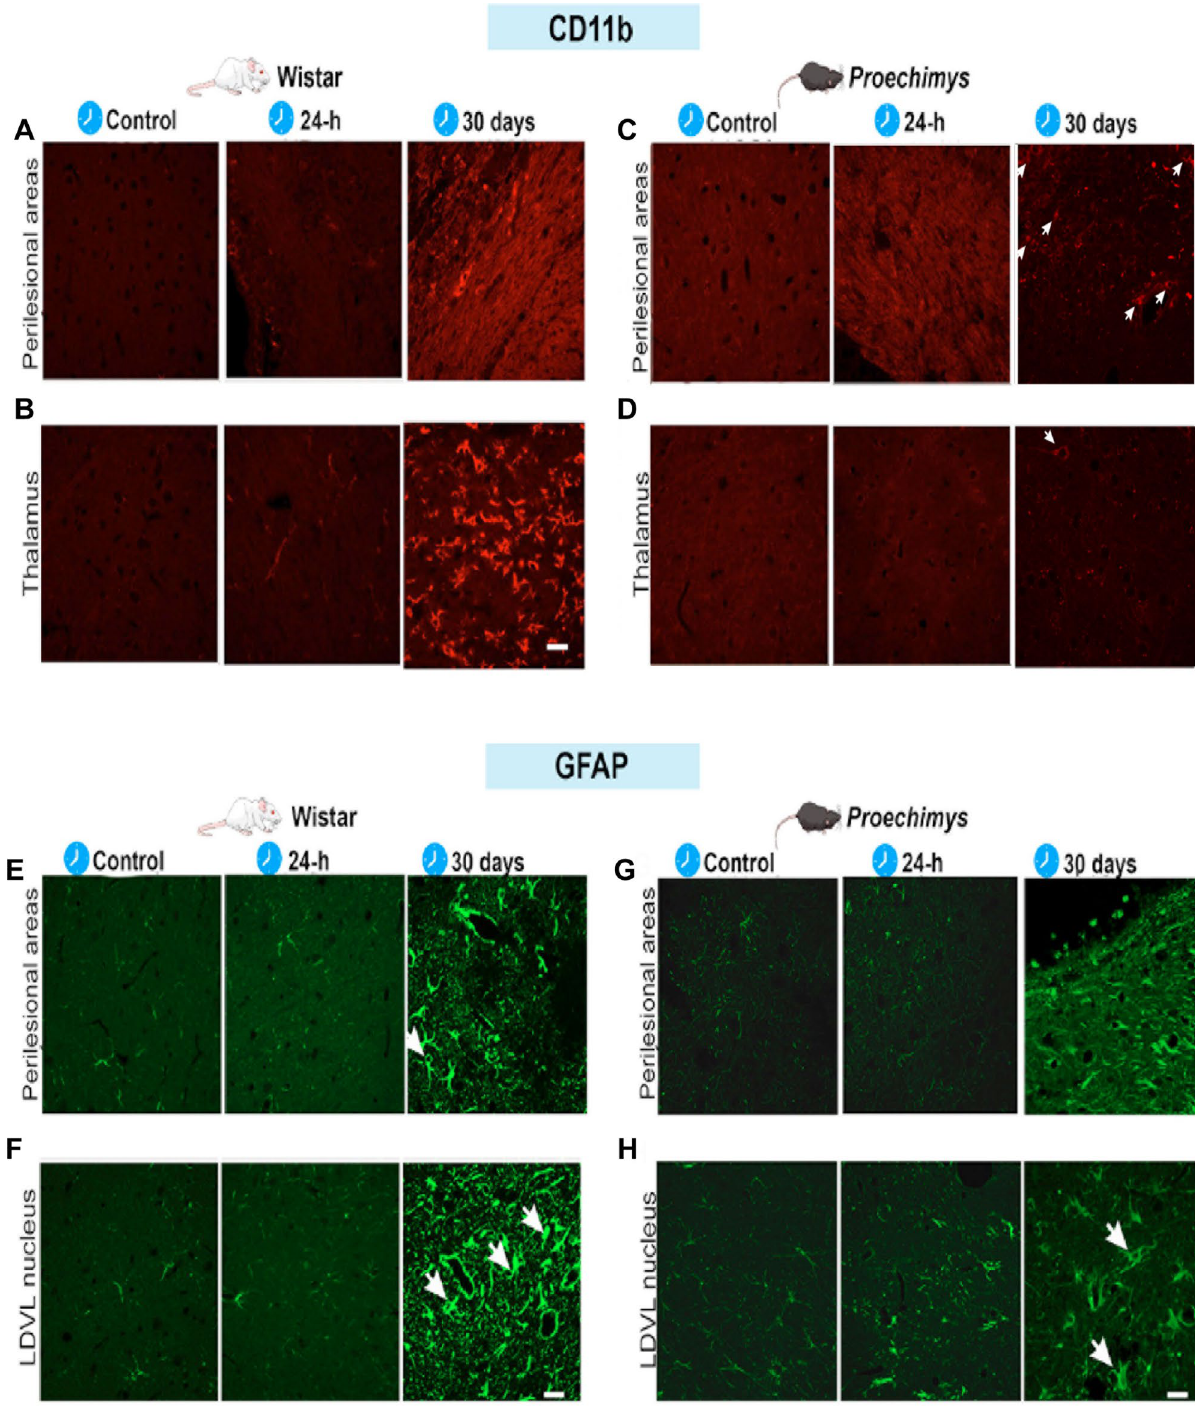
Figure 3. CD11b and GFAP immunofluorescences staining in the perilesional area and thalamus in Wistar and Proechimys . ( A – D ) Representative immunostaining images of CD11b in the perilesional area ( A , C ) and thalamus ( B , D ). Note the absence of CD11b positivity in Proechimys and increased CD11b expression at 30 days after photothrombosis in both brain regions of Wistar rats. ( E – H ) Representative images of GFAP in the perilesional area ( E , G ) and LDVL thalamic nucleus ( F , H ). In Wistar, increased expression of GFAP was found at 30 days in the perilesional area ( E ) and in several thalamic nuclei; ( F ) shows the LDVL nucleus. In Proechimys , increased expression of GFAP was solely found in the LDVL nucleus at 30 days after stroke. Scale bars 20